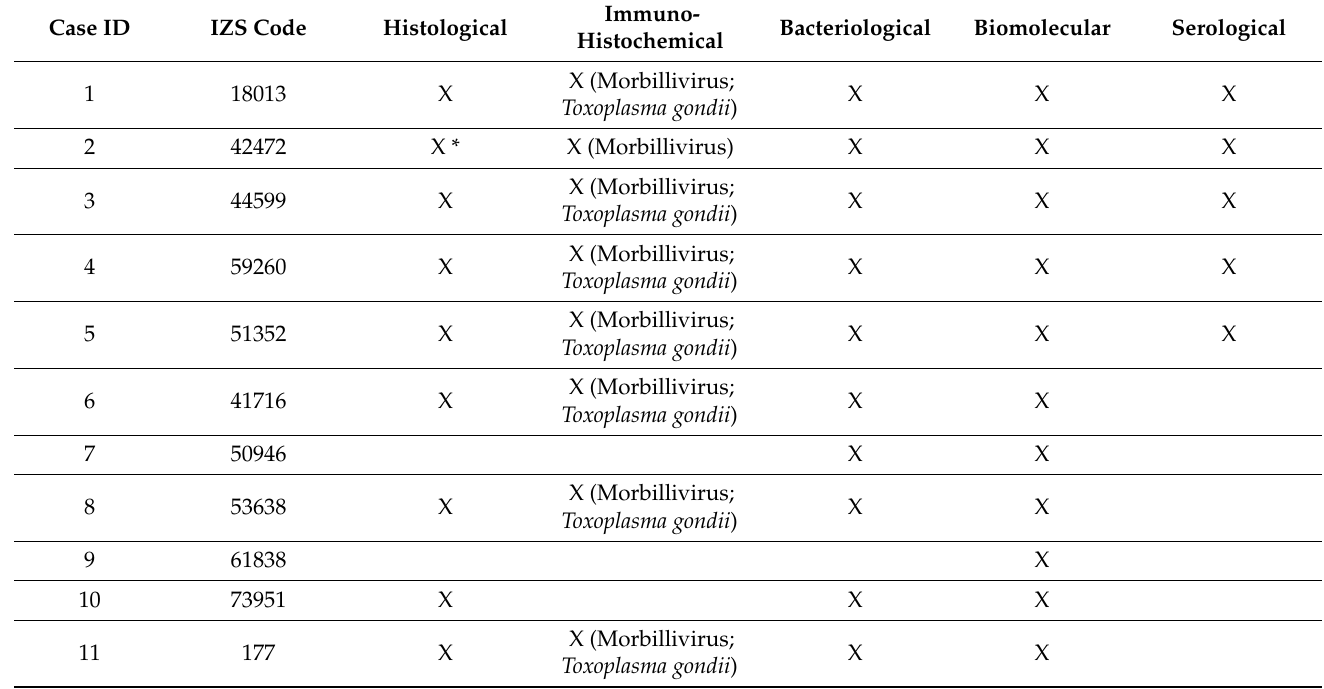
Table 1. Overview of diagnostic investigations conducted per case. Cases are listed in chronological order; the IZS identification code is also reported for each